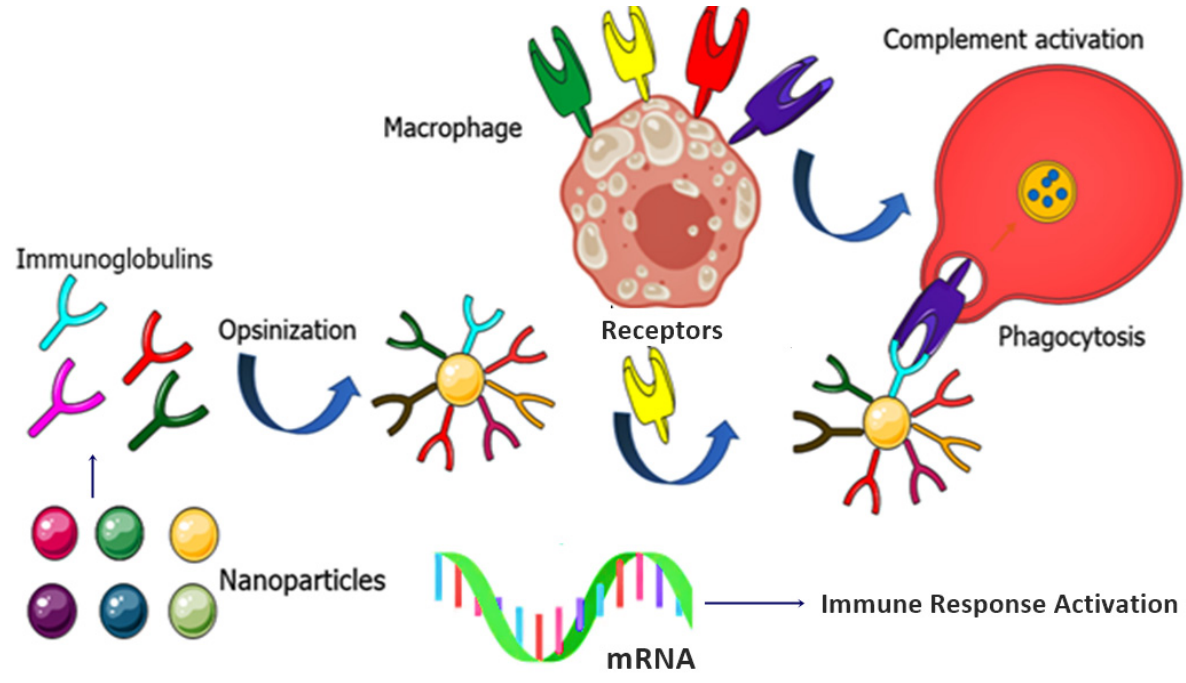
Figure 7. mRNA-based vaccines impart immunoglobulins and immune responses, leading towards phagocytosis. Table 3. List and links to information about clinical trials regarding RNA-based nanomaterials against cancer. RNA Based Nanomaterials Clinical Trials Ref.